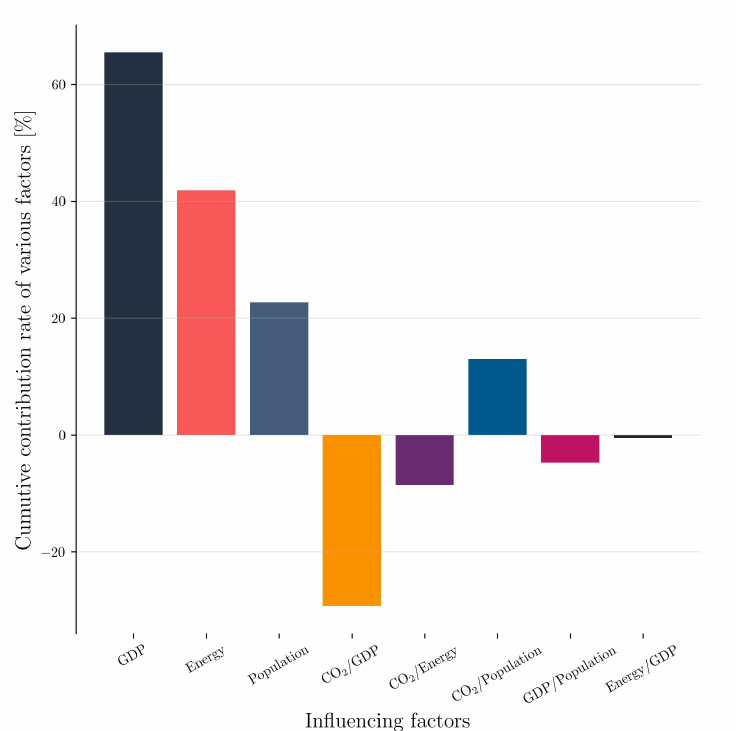
Figure 6. Cumulative contribution rate of carbon dioxide level change rate in China’s logistics industry from 2000 to